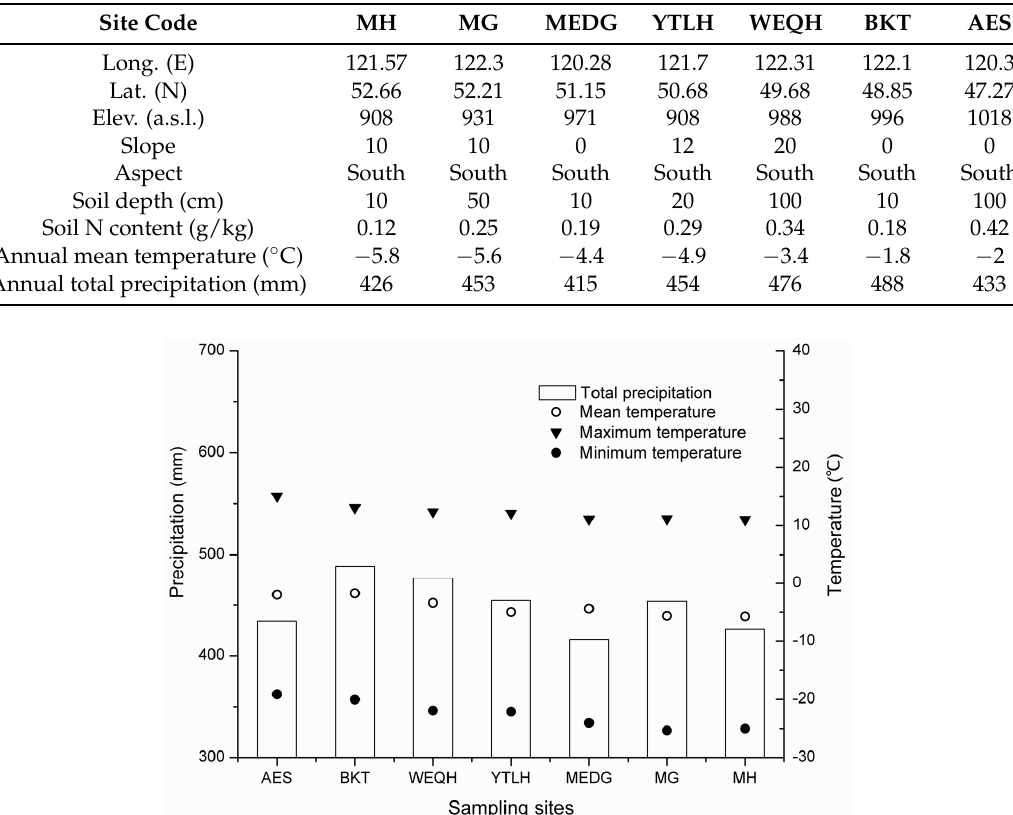
Table 1. Characteristics of the sampling sites in the western Greater Khingan Mountains, China.